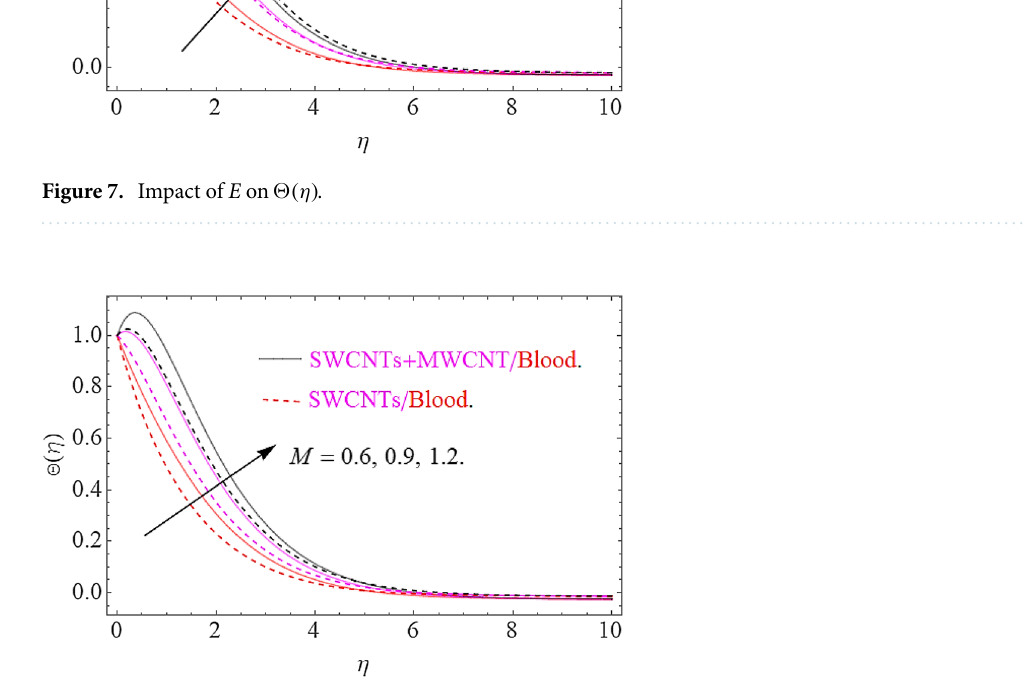
Figure 8. effects of M on �(η)